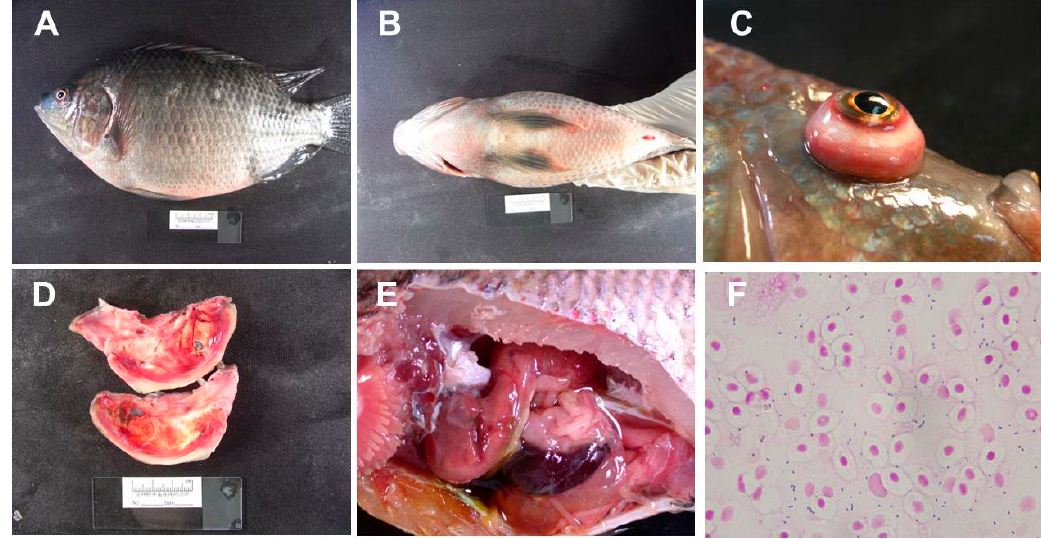
Figure 2. Gross lesions of streptococcosis in Tilapia: ( A ) skin hemorrhage; ( B ) abdominal and anus hemorrhage; ( C ) eye exophthalmos and hemorrhage; ( D ) inner opercular hemorrhage; ( E ) ascites and splenomegaly; ( F ) cocci bacteria in smear from spleen with Gram stain.